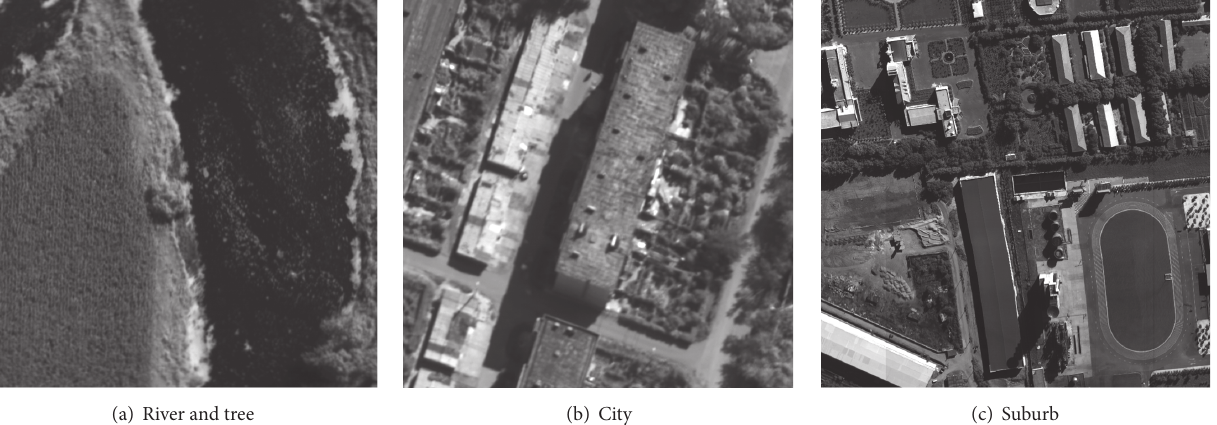
Figure 12: Test aerial images.